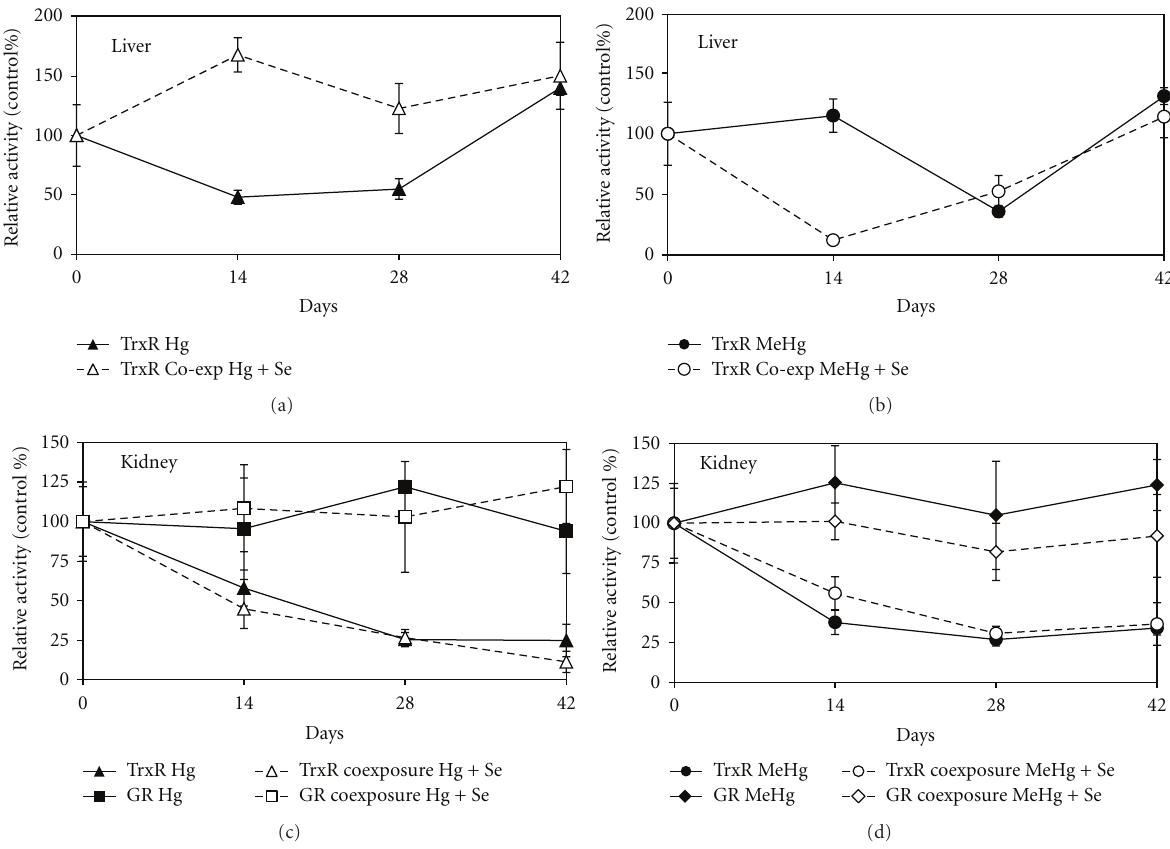
Figure 3: Enzymatic activities in liver and kidney of zeabra-seabreams exposed to mercurials and co-exposed to mercurials and Se (subset of results from a study previously reported in Branco et al. [34]). Exposure lasted 28 days and was followed by 14 days of depuration in clean or Se-supplemented water. (a) TrxR activity in the liver of seabreams exposed to Hg 2+ and co-exposed to Hg 2+ and Se; (b) TrxR activity in the liver of seabreams exposed to MeHg and co-exposed to MeHg and Se; (c) TrxR and GR activities in the kidney of seabreams exposed to Hg 2+ and co-exposed to Hg 2+ and Se; (d) TrxR and GR activities in the kidney of seabreams exposed to MeHg and co-exposed to MeHg and Se. GR activity in the liver did not show significant variation and was not represented to improve